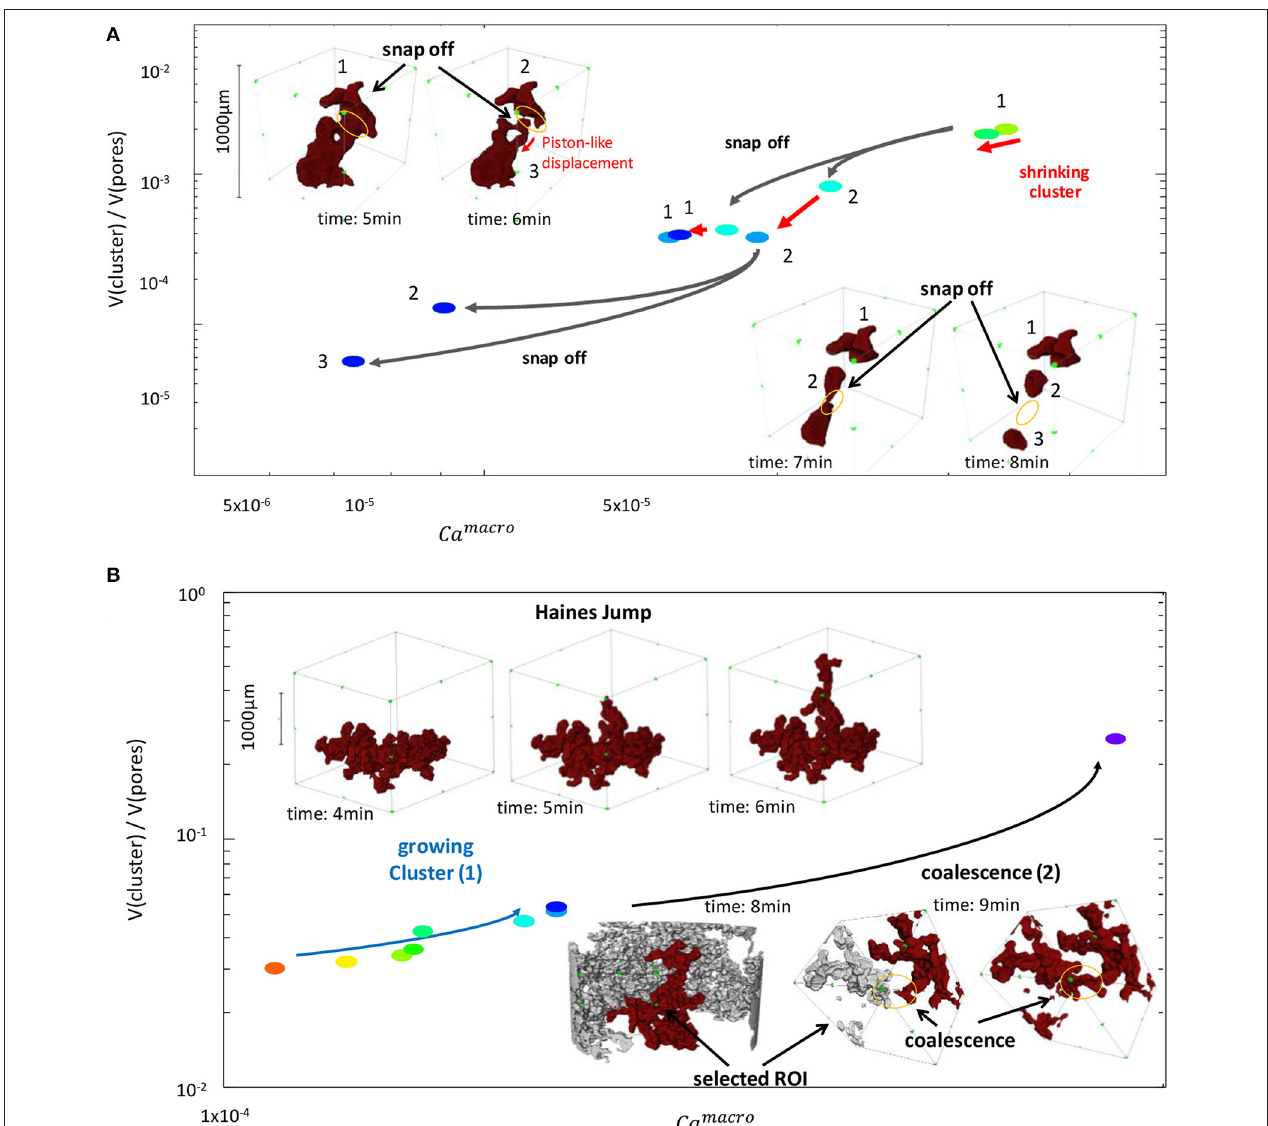
FIGURE 12 | Breakup of oil clusters (A) and coalescence (B) processes at the pore scale. Breakup occurs often by simultaneous snap-off processes in a cluster thereby preserving topological loop structures (see insets in A ). Clusters can also grow by coalescence, which is overall more a frontal propagation, whereby connectivity is maintained, and formation of loops is largely avoided. Both breakup and coalescence events impact cluster volume, i.e., saturation and cluster length, i.e., the macroscopic capillary number, which is proportional to the viscous pressure drop over the cluster